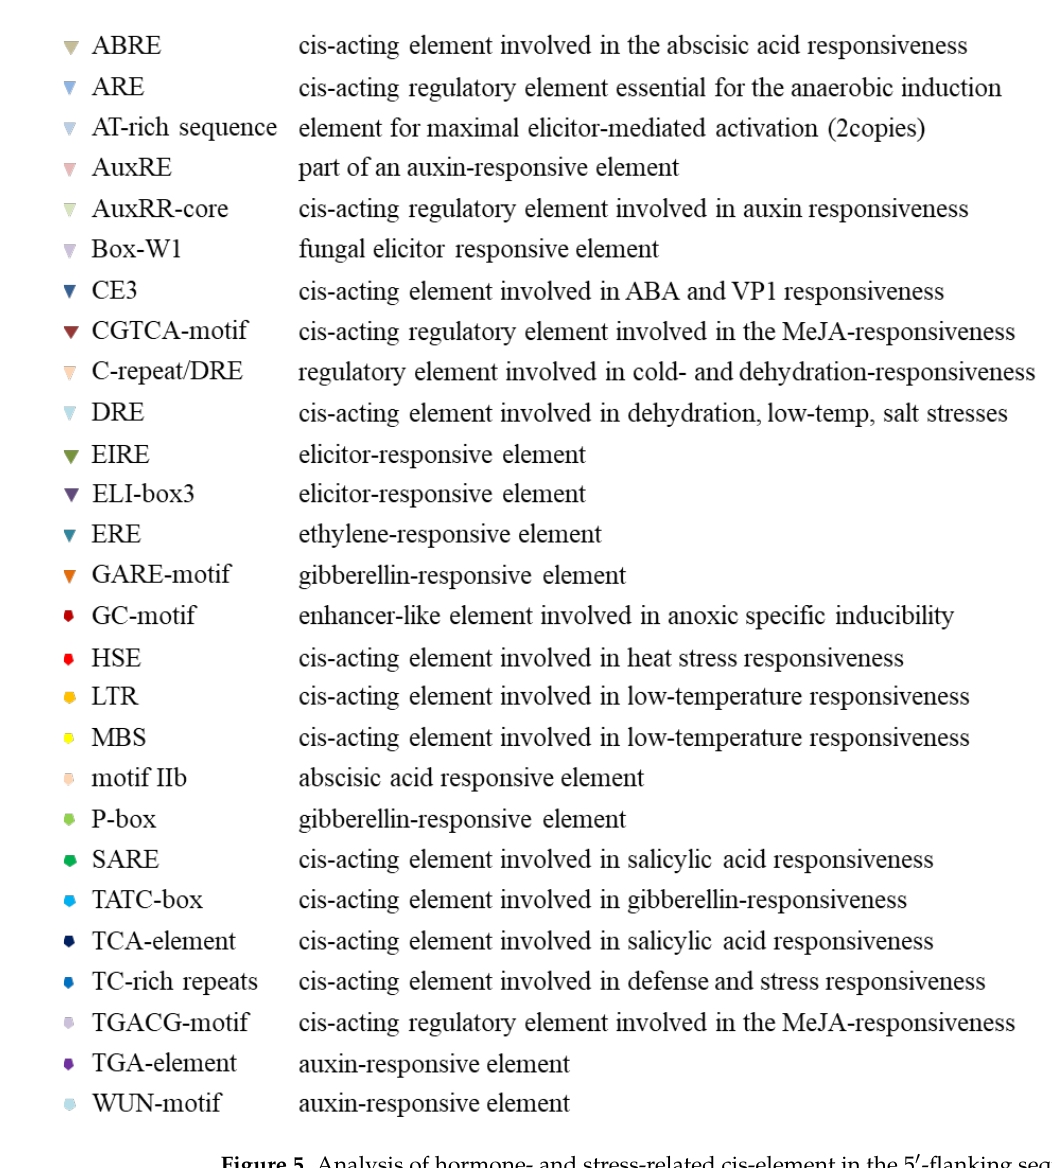
Figure 5. Analysis of hormone- and stress-related cis-element in the 5′ -flanking sequences of plant SF3a2 genes. Different symbols in different colors represent a total of 27 putative cis-elements. The function of every motif is listed next to the symbol. These motifs are marked along 1.5kb 5′ -flanking sequences before every gene. Downward triangles and pentagons mean that this element was on the positive-sense strand. On the contrary, the upturned triangles and pentagons mean that they were on the antisense strand. The red dotted line shows no sequences. The black dotted line represents the regions of annexed base N. The full line represents the regions with explicit basic pairs.